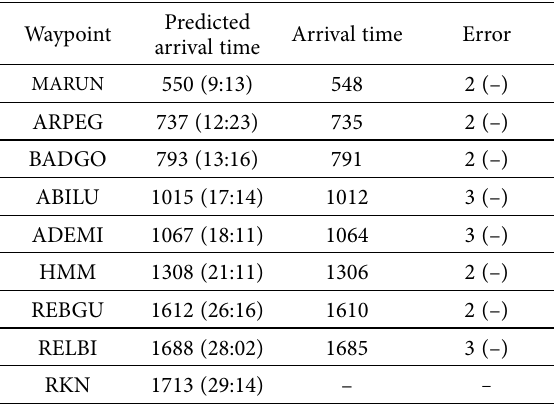
Table 3. Comparison of arrival time with respect to